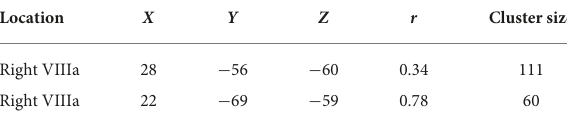
TABLE 4 Montreal Neurological Institute (MNI) coordinates for correlations between regional grey matter volume and Conners ADHD Index t